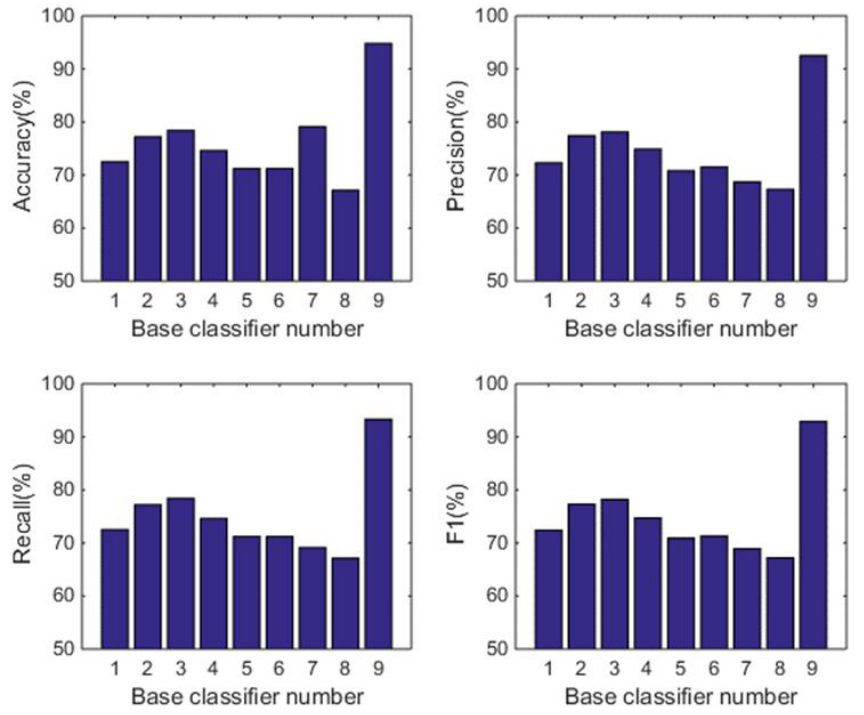
Figure 4. Performance comparison between base classifiers (1–8) and our fused classifier (9) for subject 1 in OPPORTUNITY dataset.